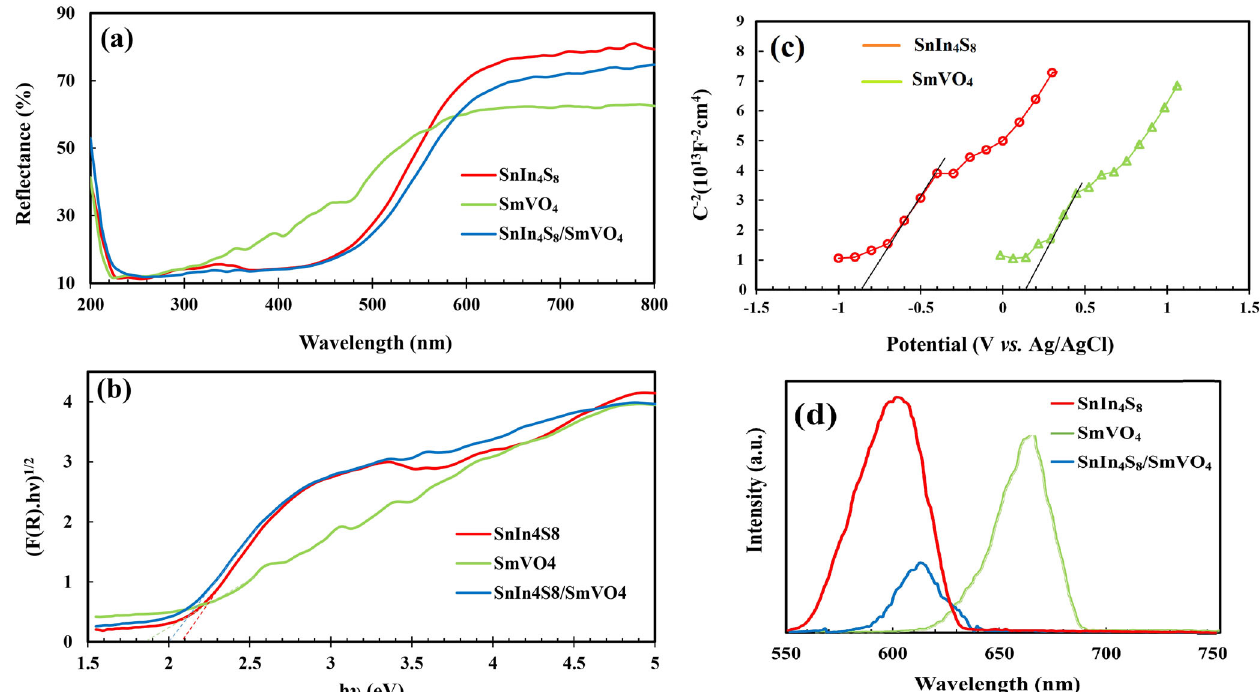
Fig. 4 Plots of the optical properties of the synthesized samples. a UV-Vis DRS. b [F(R)h υ ] 1/2 versus h υ . c Mott-Schottky. d PL.